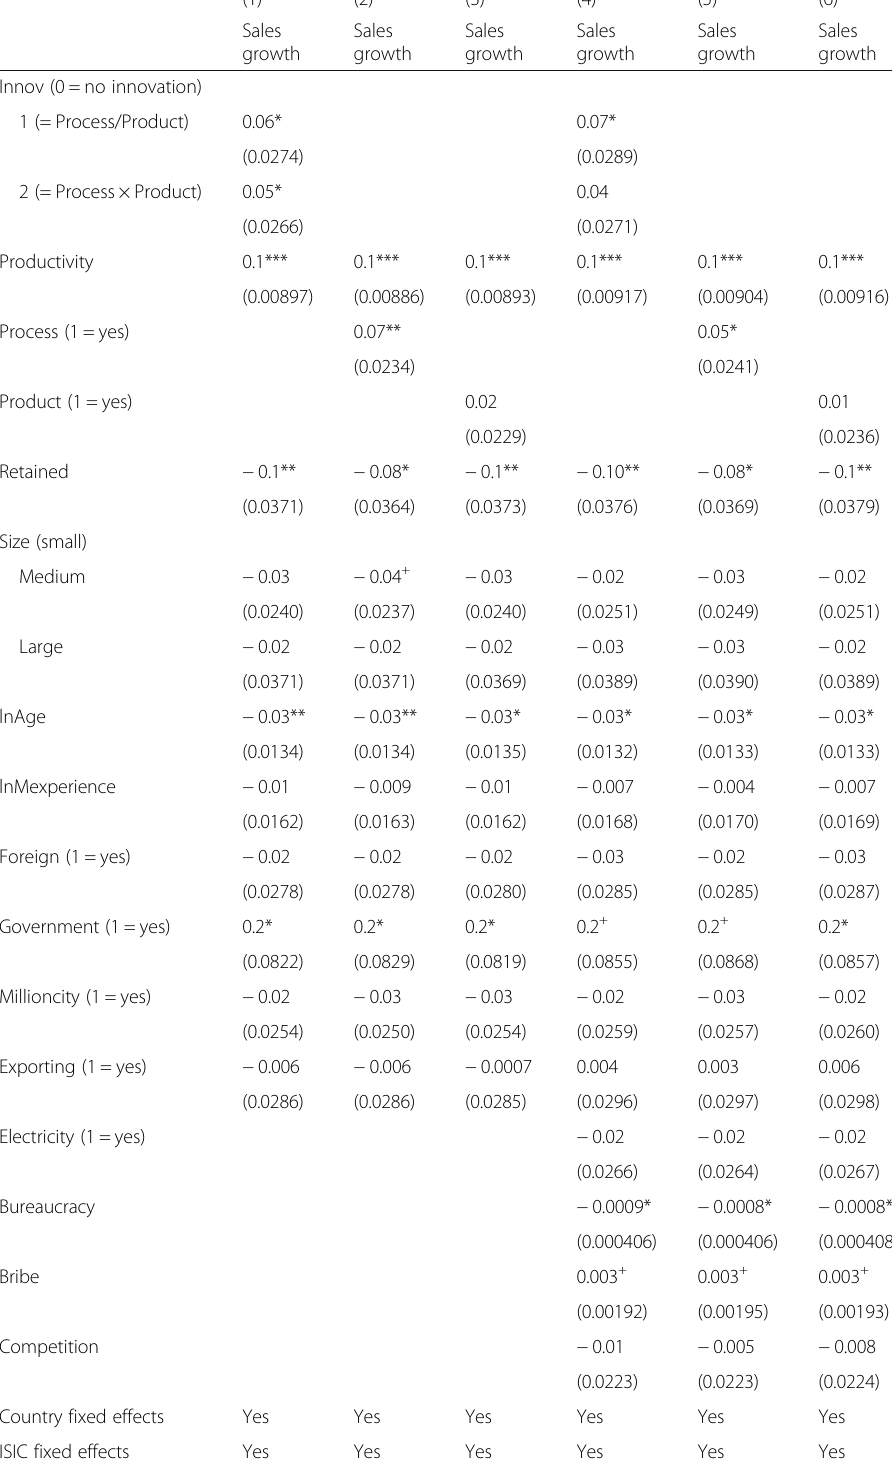
Table 10 Sales growth and